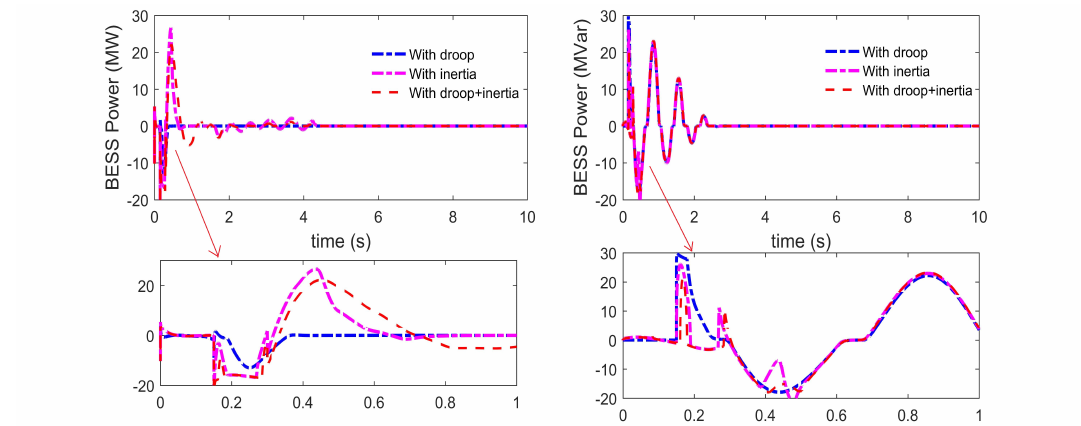
Figure 16. The active and reactive power of BESS with a single-phase-to-ground